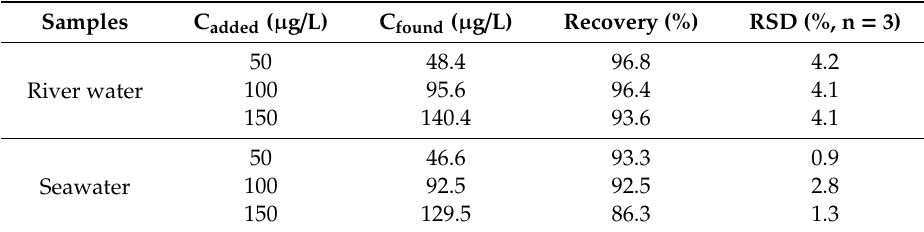
Table 3. Recoveries of methylene blue in di ff erent samples (n = 3).